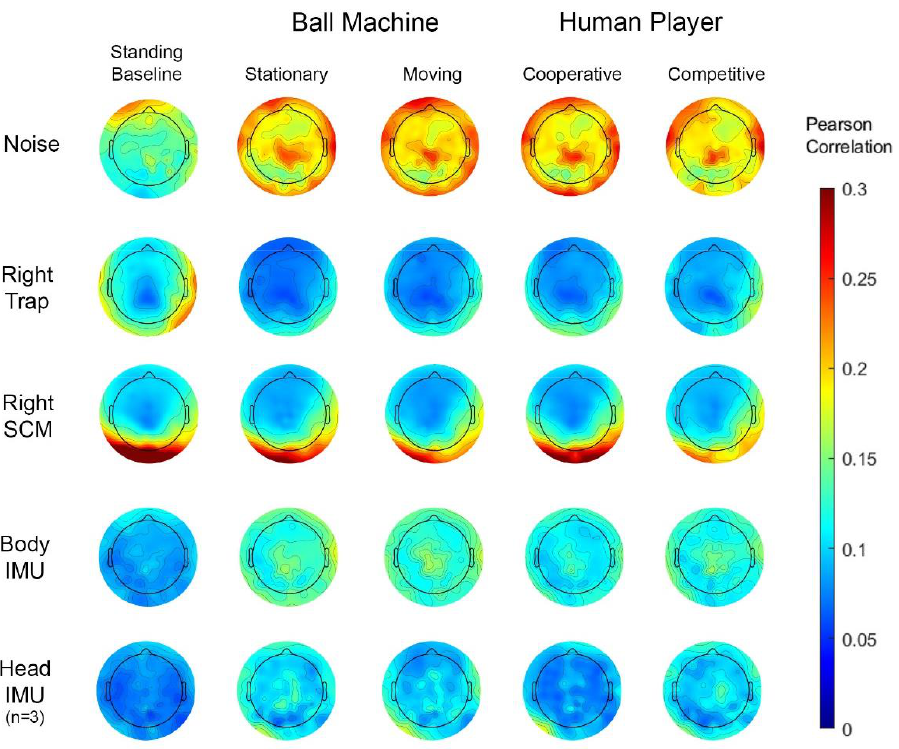
Figure 6. Group average time series correlations of individual scalp electrodes with paired noise electrodes (row 1), right trapezius (trap) muscle (row 2), right sternocleidomastoid muscles (row 3), and resultant body IMU acceleration (row 4) with n = 20 participants. The scalp electrode correlation